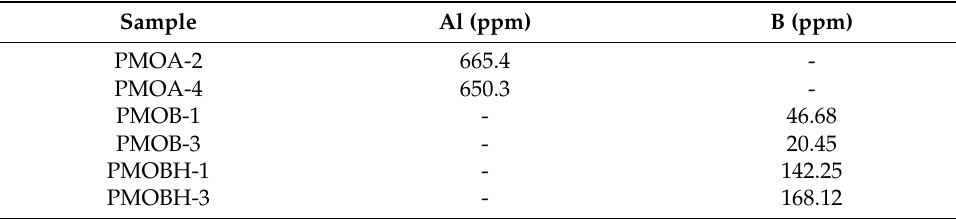
Table 4. ICP-AES measurements for the selected